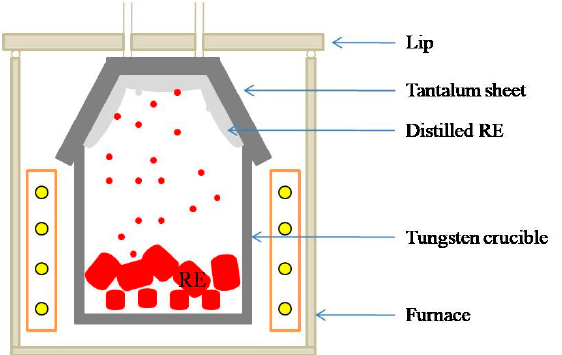
Figure 5. Schematic diagram of vacuum distillation.